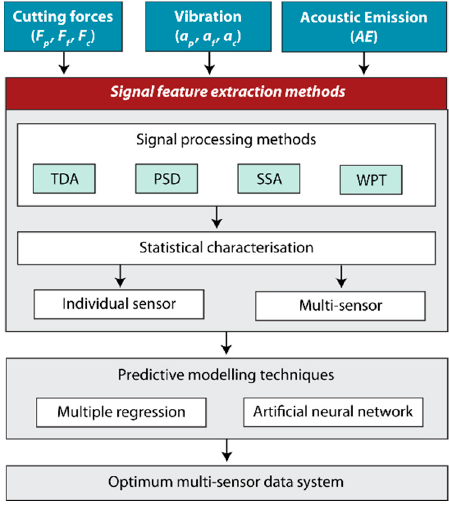
Figure 2. Methodology. Table 1. Signal characterization parameters